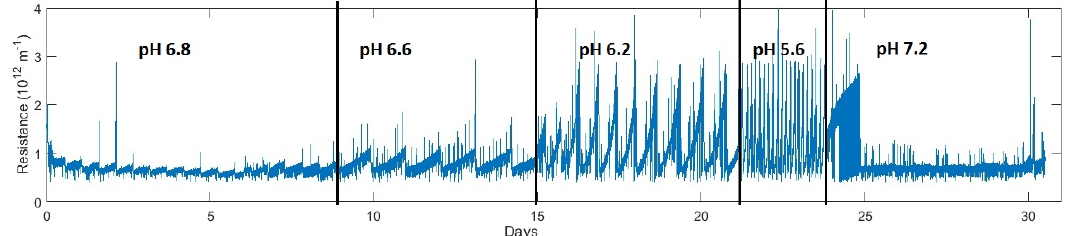
Figure 1. Total resistance (membrane and fouling, temperature corrected) for HFUF with PACl as coagulant, pH changing over time, flux 50 L/m 2 h (the first seven days, normalized flux 80 L/m 2 h) and 75 L/m 2 h (water temperature 2.5 °C, normalized flux 120 L/m 2 h).